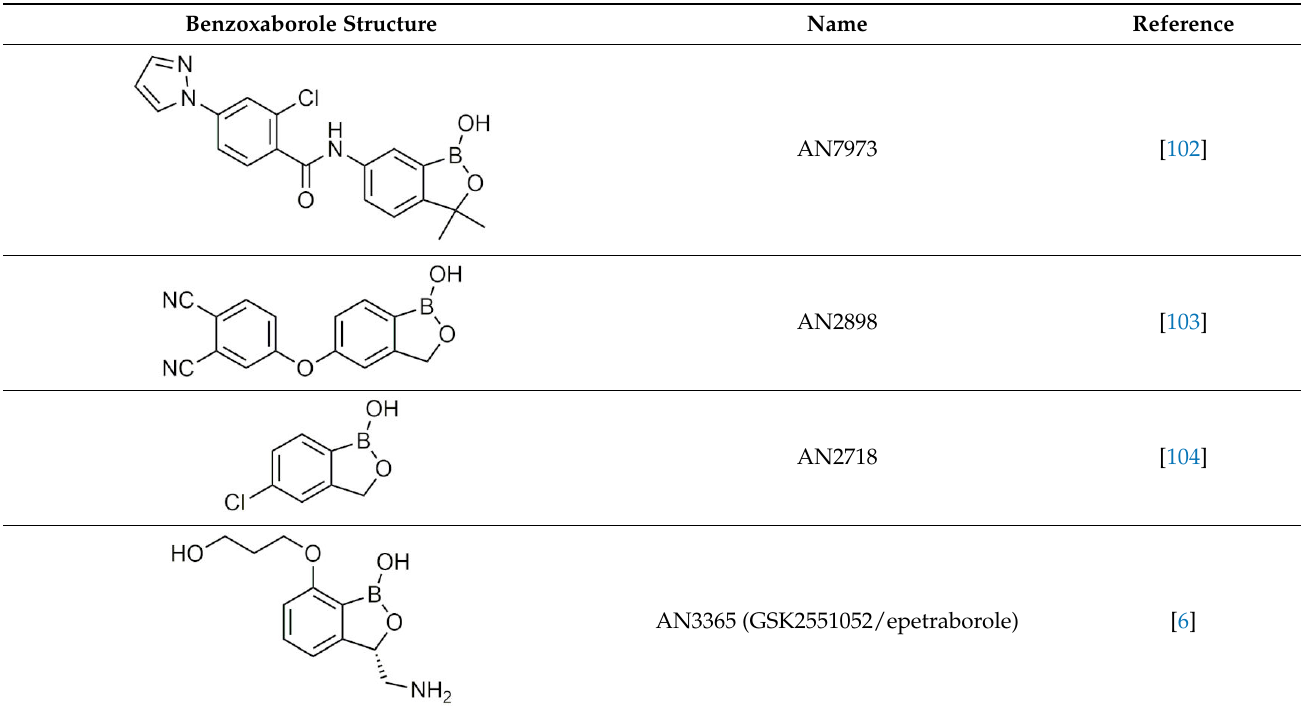
Table 4. Benzoxaborole medicinal